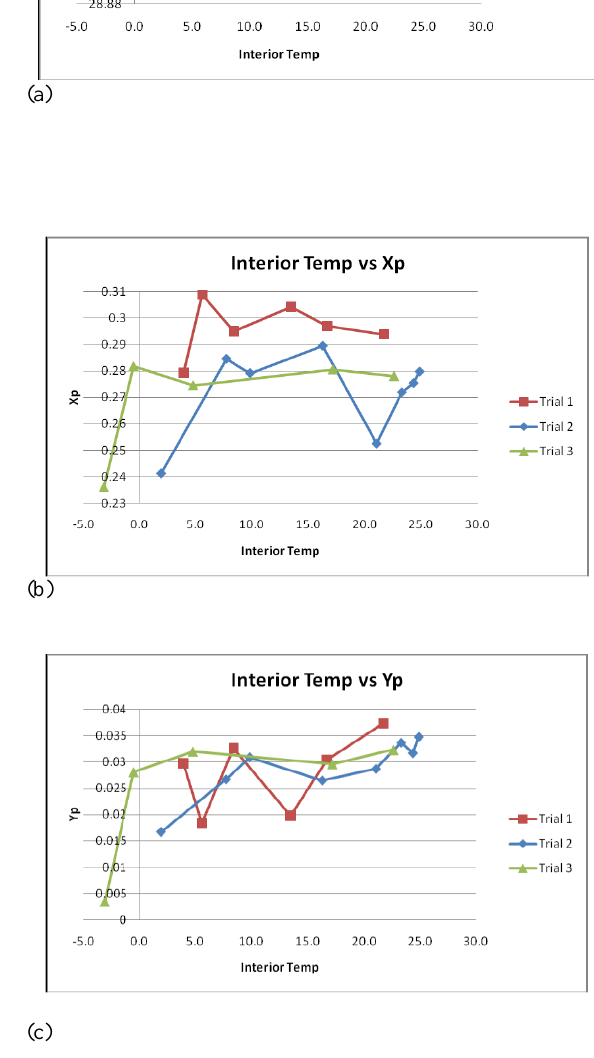
Figure 6. (a): shows the effect of temperature changes on the focal length which is approximately 0.01 mm per every 10 degrees temperature changes, i.e. 0.03mm for 30 degrees. (b) and (c) shows the effect of temperature changes on the principal point position(Xp,Yp). This is important when the camera is calibrated in the lab environment but is operated in a different temperature